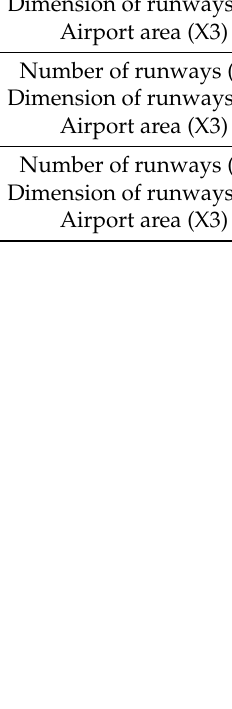
Table 7. The efficiency score of DEA models during